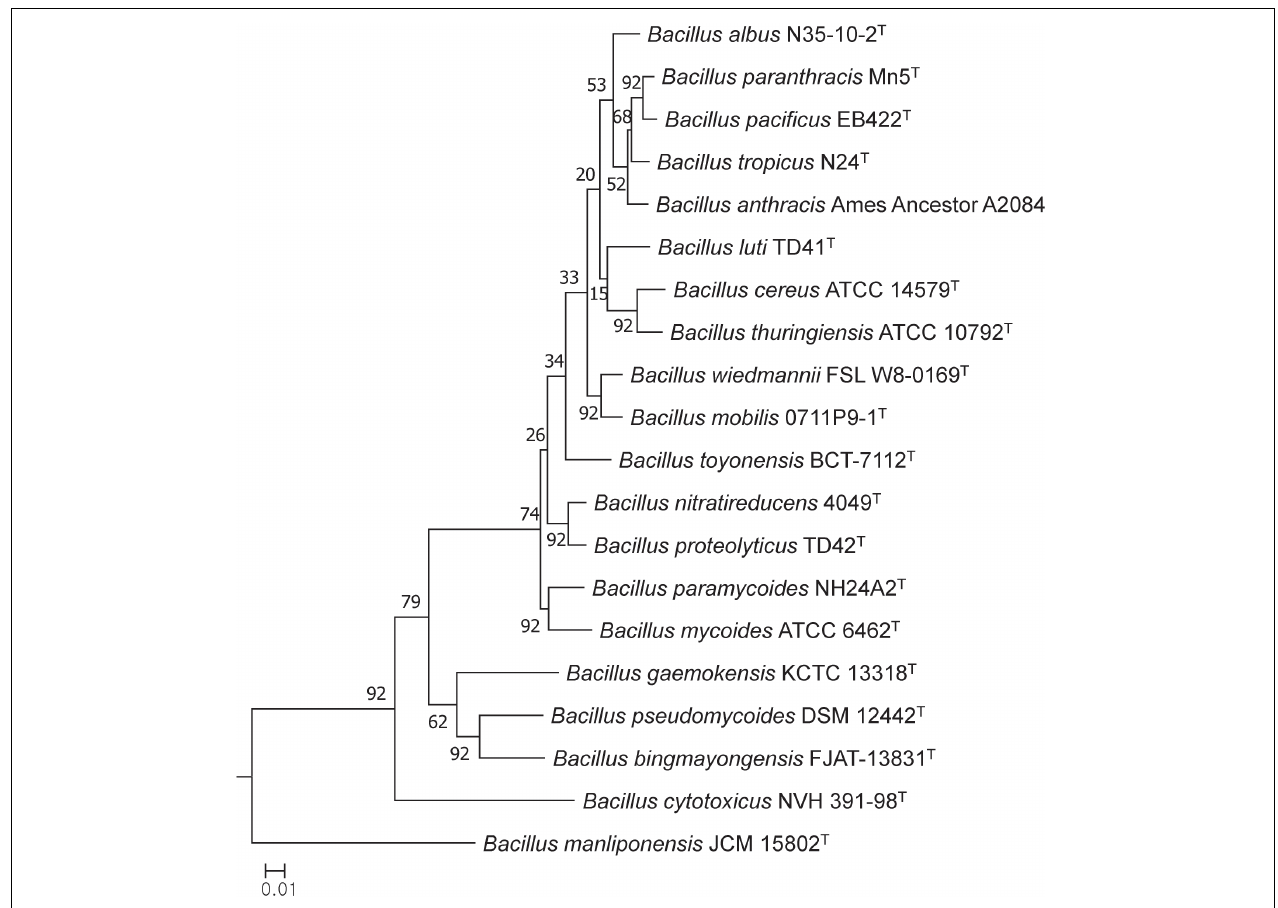
FIGURE 1 | Maximum-likelihood tree based on 92 single copy core gene sequences showing relationships between the type trains of B. cereus and B. thuringiensis and between them and corresponding strains of other B. cereus sensu lato species. The numbers at the nodes are bootstrap values based on 1000 replicates. The bar stands for the number of substitutions per